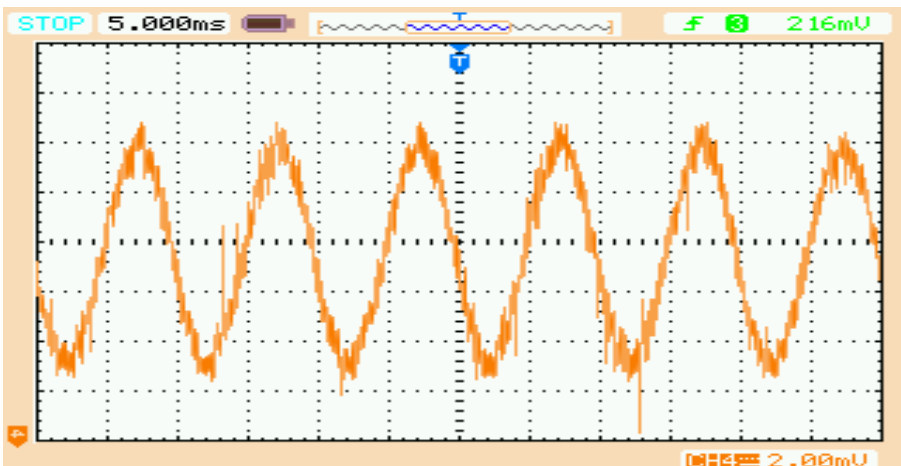
Figure 23. Output voltage profile of proposed scheme.